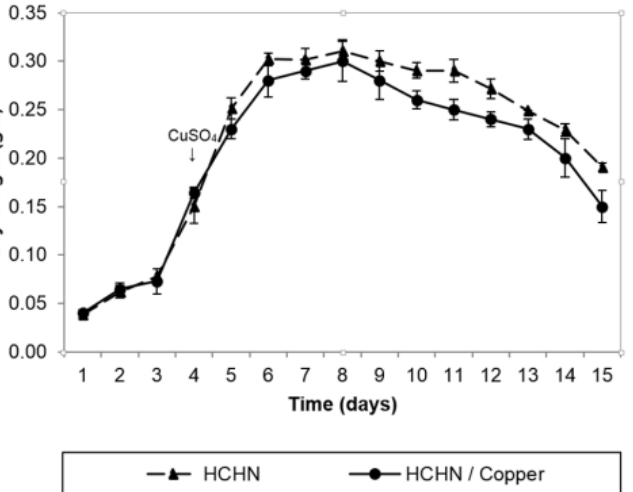
Figure 5. Growth kinetics of T. terrestris Co3Bag1 in HCHN/Copper. Growth kinetics in HCHN ( ▲ , dotted line) and HCHN/Copper (1 mM CuSO 4 ) ( • , continuous line) medium. Growth was monitored by dry cell weight.